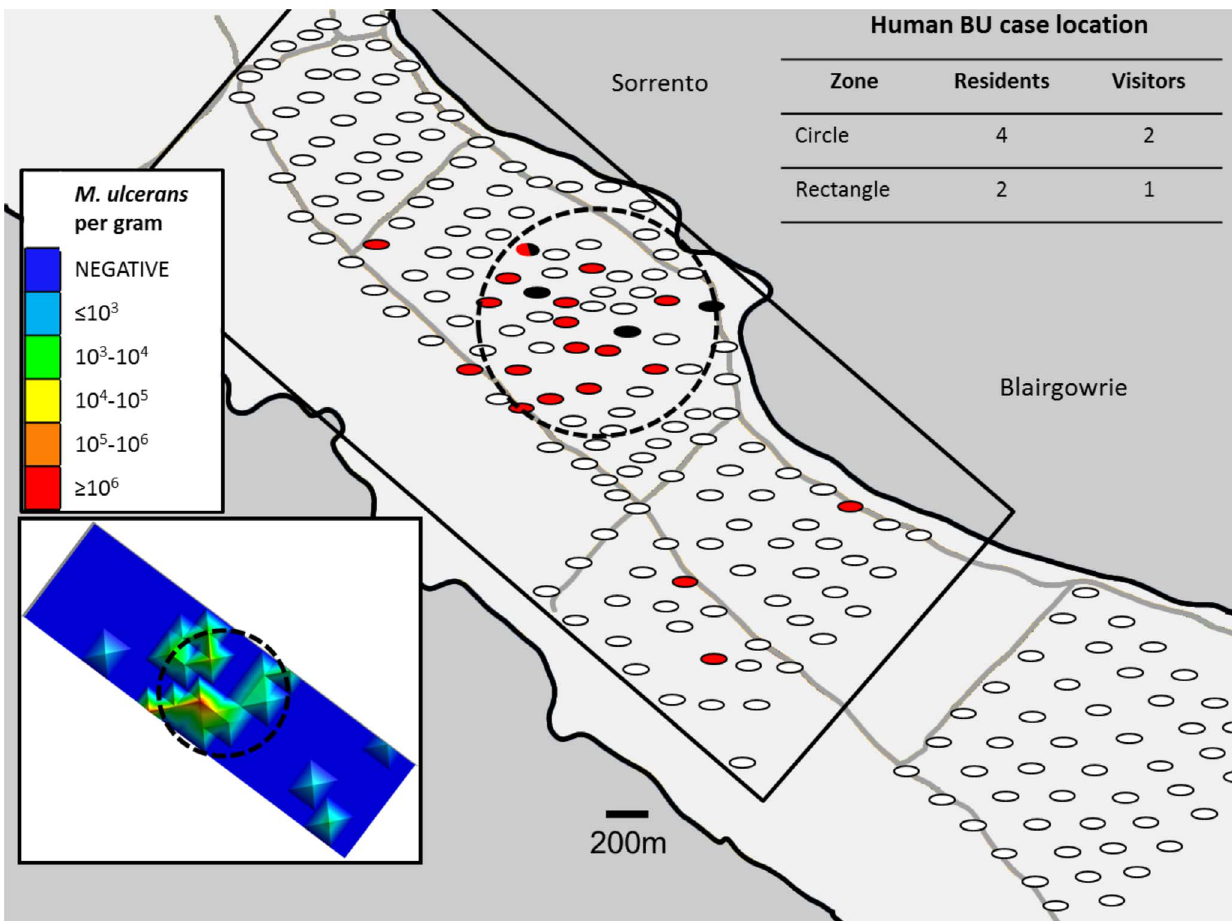
Figure 2. Map showing the distribution of collection sites for possum faeces, indicating the locations of positive samples for Mycobacteriumulcerans DNA by real-time IS 2404 PCR. The locations of positive ringtail faecal samples are shown as red ovals; positive brushtail samples are shown as black ovals: negative samples are shown in white. The dotted circle shows a significant non-random clustering of Mycobacterium ulcerans positive possum faecal samples identified by spatial scan statistics ( P , 0.0001; 16/30 possum faecal sample positives within a circle of radius 0.42 km). 4/6 residential addresses of human BU cases and 2/3 non-resident addresses fall within the radius of the cluster identified above. Addresses of holiday houses were unavailable for 3 non-resident BU cases. The inset figure (bottom left) depicts a heat map showing possum faecal bacterial loads of samples within the black rectangle, estimated from IS 2404 real-time PCR signal strength, ranging from negative (dark blue) to $ 10 6 M. ulcerans per gram of faeces